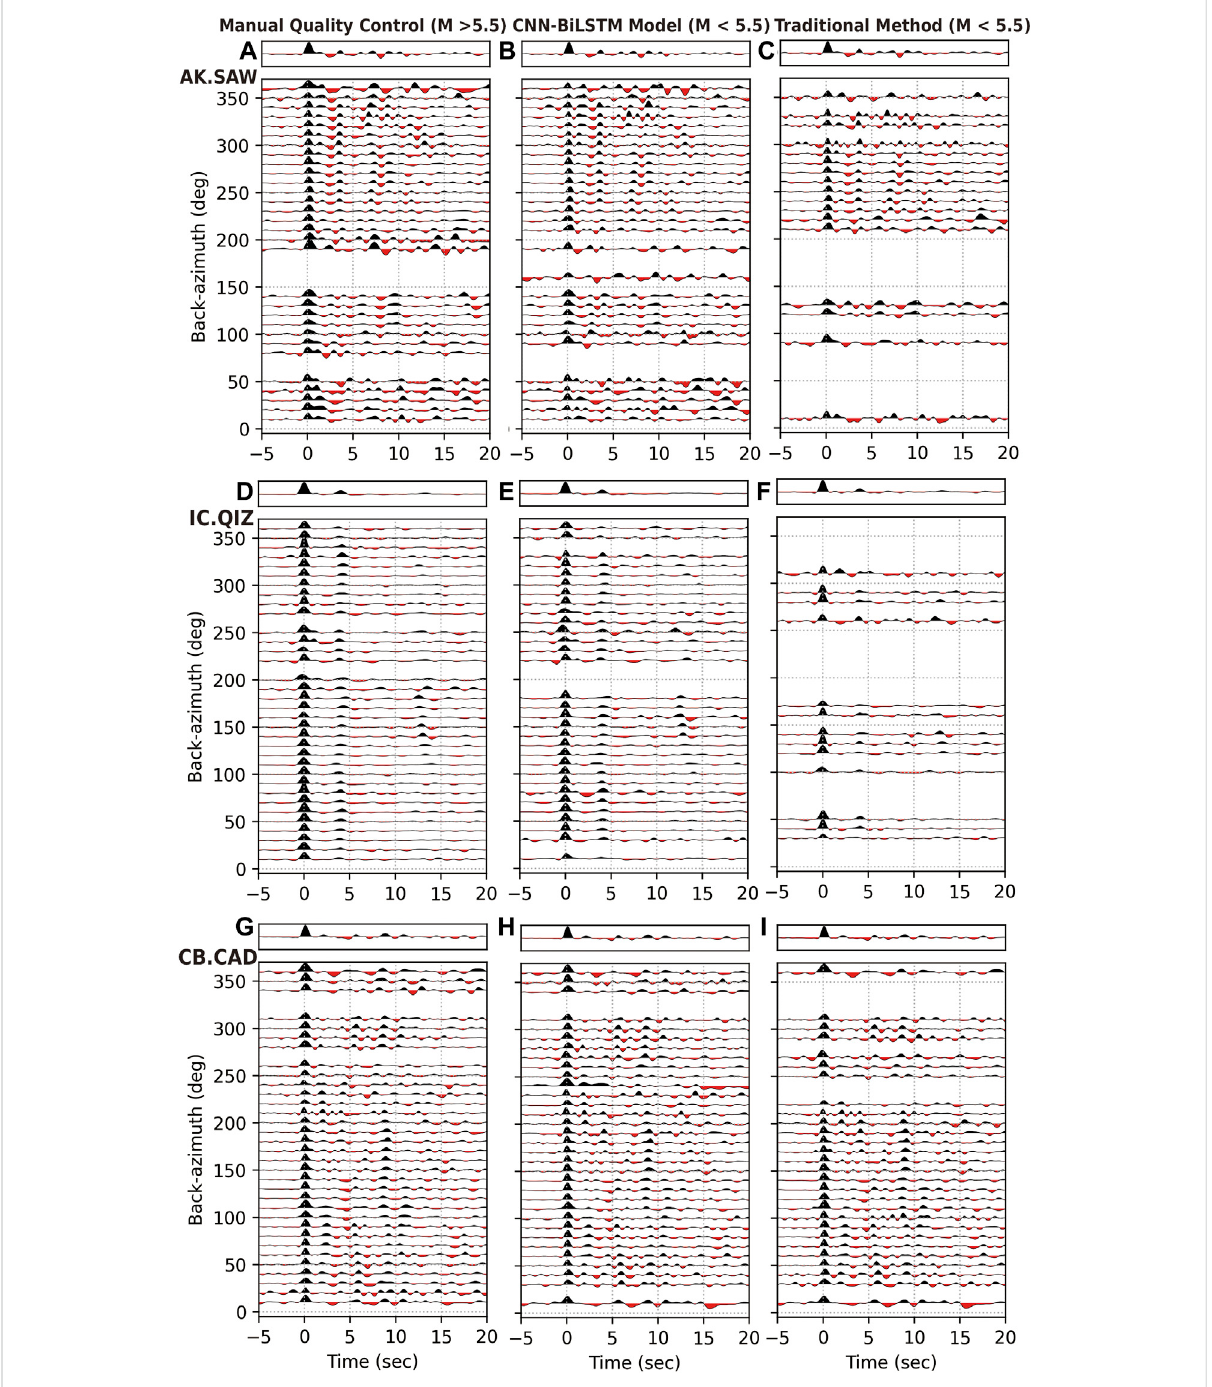
FIGURE 4 Receiver functions stacked in each back-azimuth bin. (A – C) Three “ good ” AK. SAW datasets (manually quality controlled dataset with magnitudes larger than 5.5, automatically quality controlled dataset by the CNN-BiLSTM model with magnitudes between 5.0 and 5.5 and automaticallyqualitycontrolled dataset bythetraditional method inHiPerSeiswith magnitudesbetween5.0 and5.5).The summational traces inthe toppanels. (D – F) arethesameas (A – C) butforthree “ good ” IC.QIZdatasets. (G – I) arethesameas (A – C) butforthree “ good ”